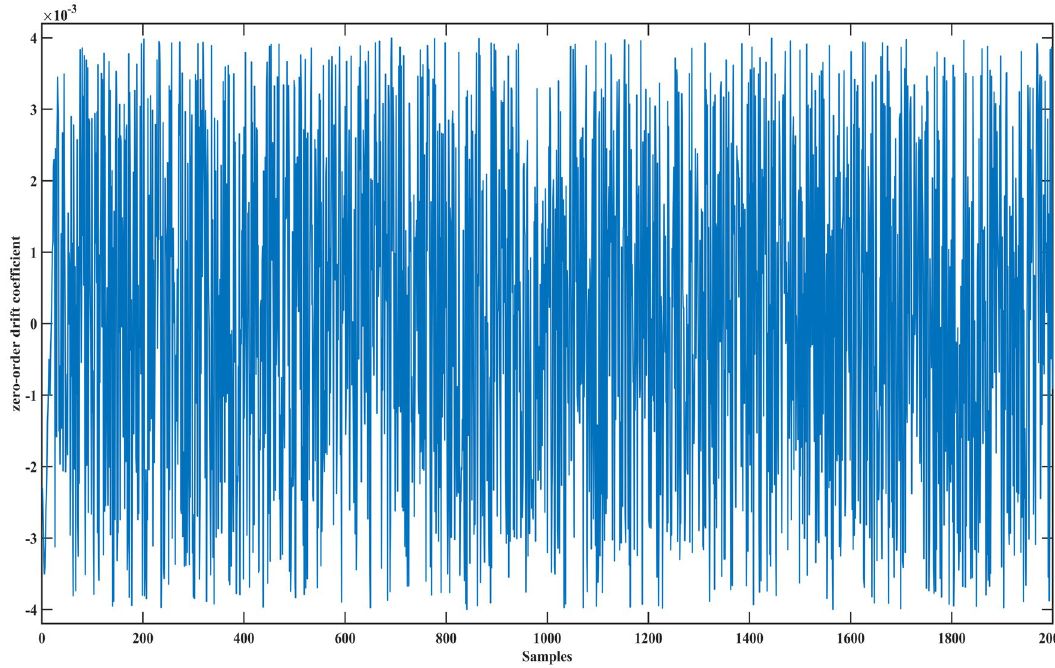
Figure 1. The zero-order drift coefficient of the laser gyro.